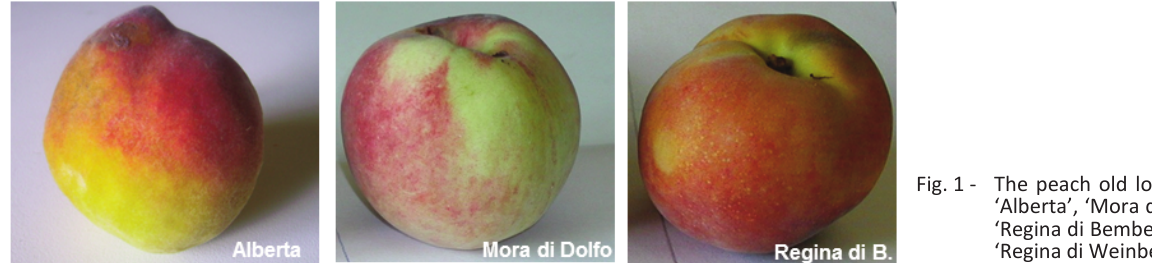
Fig. 1 - The peach old local varieties ‘Alberta’, ‘Mora di Dolfo’ and ‘Regina di Bember’ (originally ‘Regina di Weinberger’).